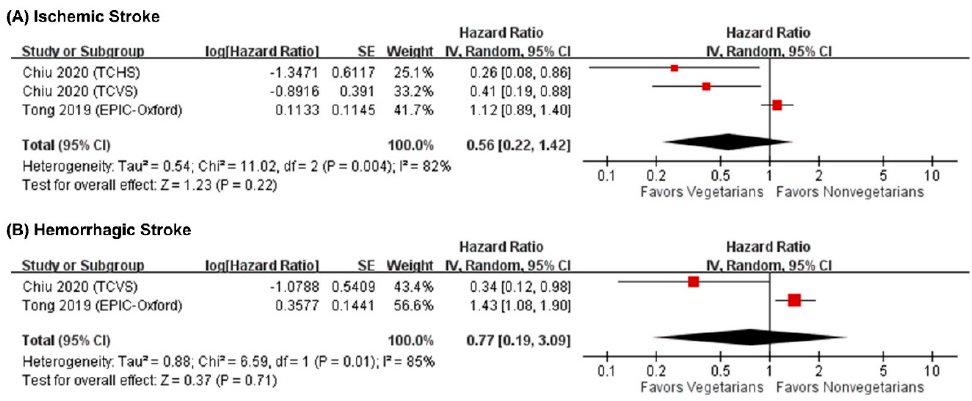
Figure 2. Forest plots showing the associations of a vegetarian diet and the risks of ischemic and hemorrhagic stroke. The meta-analysis showed that there was no association between a vegetarian diet and the risk of ischemic stroke or hemorrhagic stroke. CI, confidence interval; IV, inverse variance; SE, standard error. Table 2 summarized the results of the subgroup analysis. Studies with a mean baseline